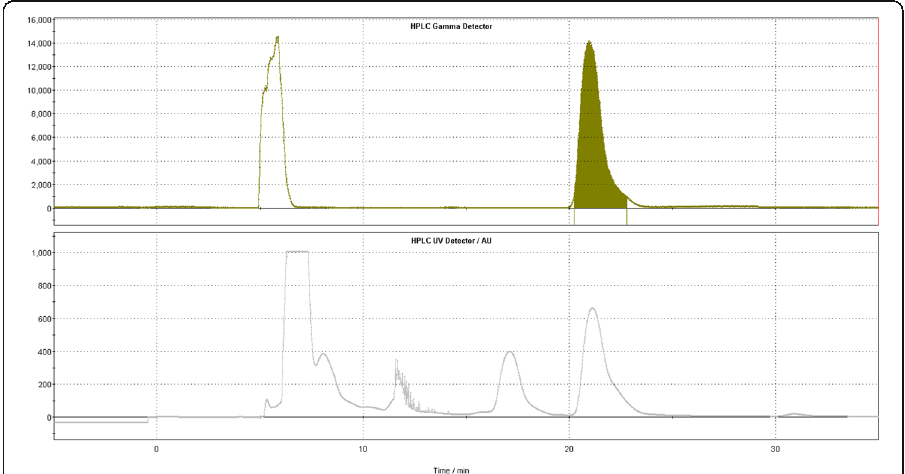
Fig. 1 Typical semi-preparative HPLC trace from synthesis of [ 18